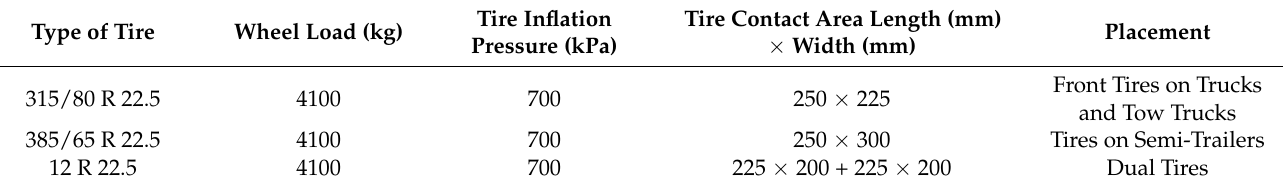
Table 4. Modeled tire types and contact areas.